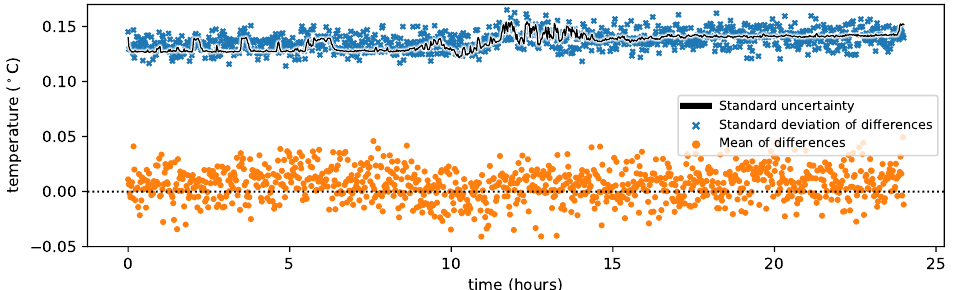
Figure 5. Temporal variation of the standard uncertainty of the estimated temperature, and the mean and standard deviation of the differences between the estimated and reference